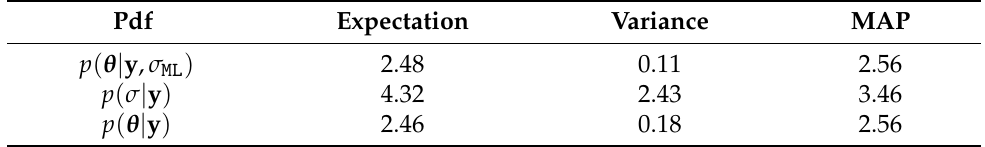
Table 1. Summary of pdfs and ground-truths for the first numerical